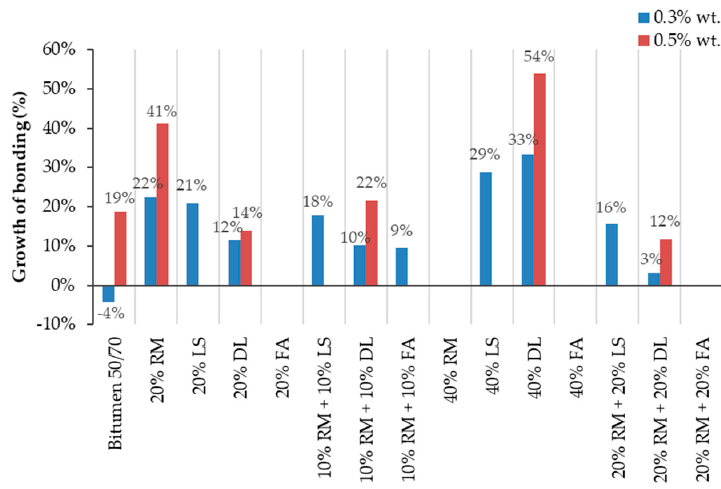
Figure 8. The growth rate of bonding properties relative to samples without an additive.